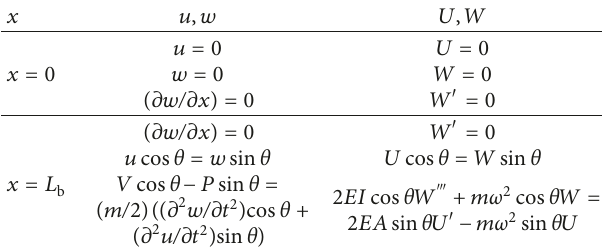
Table 1: Boundary and continuity